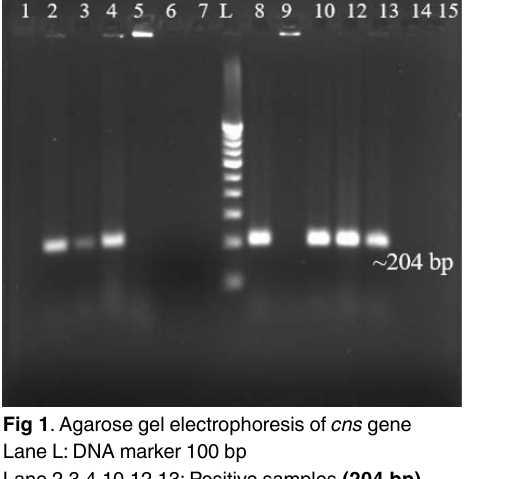
Fig 1 . Agarose gel electrophoresis of cns gene Lane L: DNA marker 100 bp Lane 2,3,4,10,12,13: Positive samples (204 bp) Lane 7:Negative control Lane 8:Positive